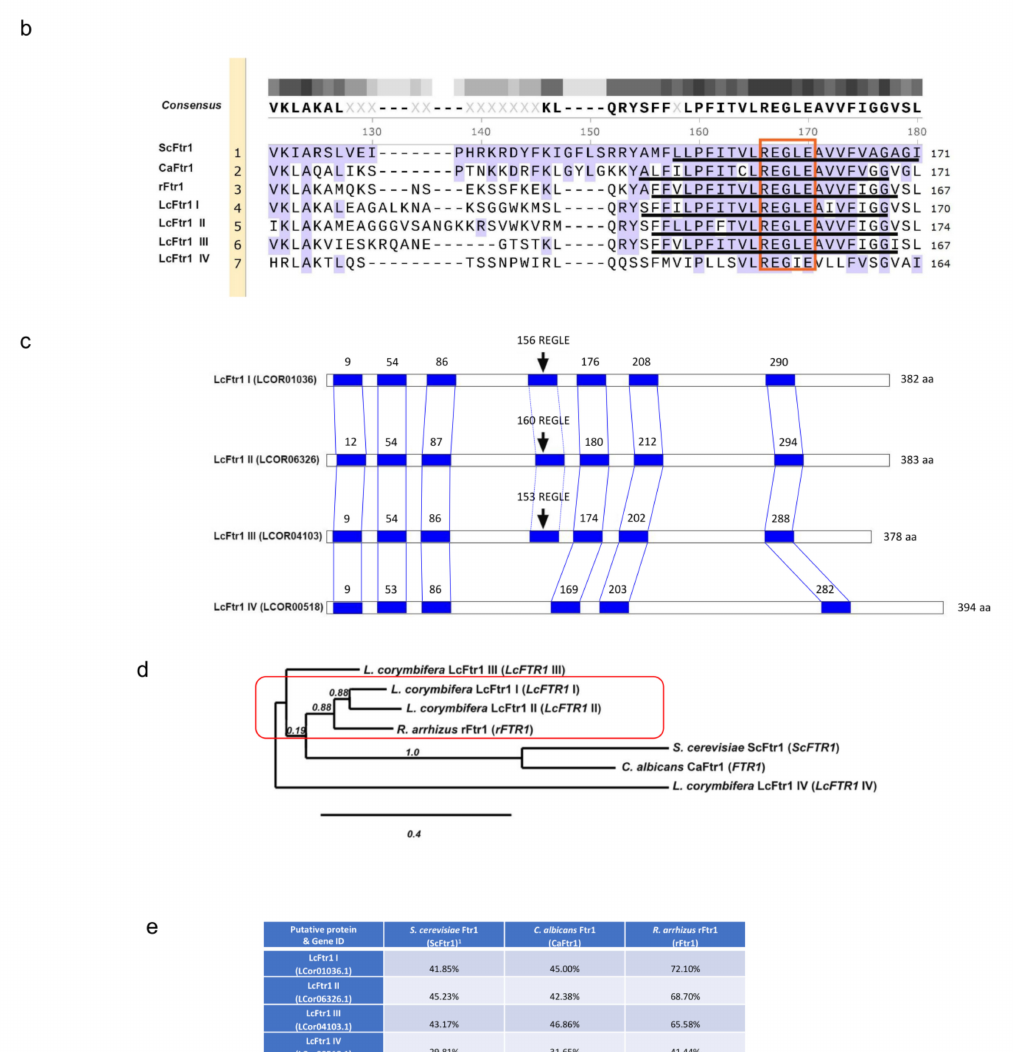
Figure 6. Phylogenetic analysis of the iron permeases (Ftr1) from different fungi. ( a ) Phylogenetic alignment of was completed using the amino acid sequences from different fungi were obtained from the respective genome database or NCBI and used for analysis. The alignment was completed using the maximum likelihood method implemented in the PhyML program (v3.1/3.0 aLRT). The WAG substitution model was selected assuming an estimated proportion of invariant sites (of 0.233) and 4 gamma-distributed rate categories to account for rate heterogeneity across sites. The gamma shape parameter was estimated directly from the data (gamma = 1.620). Reliability for internal branch was assessed using the aLRT test (SH-Like) [102–109]. ( b ) Amino acid sequence alignment indicating the REGLE motif (red box) embedded in the transmembrane domain (black lines) [25]. ( c ) Schematic representation of the predicted transmembrane domains (TM) of the four putative LcFTR1 copies. LcFtr1 amino acid (aa) are illustrated as the rectangle box; predicted TMs are indicating by the blue bars (numbers are the LcFtr1 amino acid numbers referring to the first amino acid of each transmembrane domain). The location of the REGLE motifs is indicated by the arrows (numbers denote the first amino acid of the motif). The number of amino acids (aa) of each protein is indicated adjacent to the sequences. ( d ) Amino acid alignment of the R. arrhizus permease ( rFTR1 ), S. cerevisiae permease ( ScFTR1 ) and C. albicans permease ( CaFTR1 ) with the putatively encoding L. corymbifera iron permeases ( LcFTR1 I-IV). Abbreviations: LcFTR1 : L. corymbifera; L.ramosa: L. ramosa;